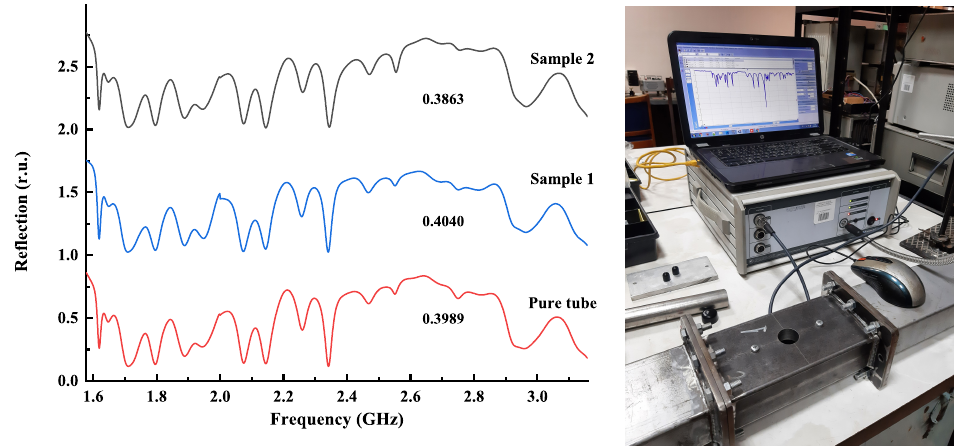
Figure 11. Reflection coefficients for pure tube, homogeneous EAF dust–biochar pellet (Sample 1), and radially heterogeneous pellet (Sample